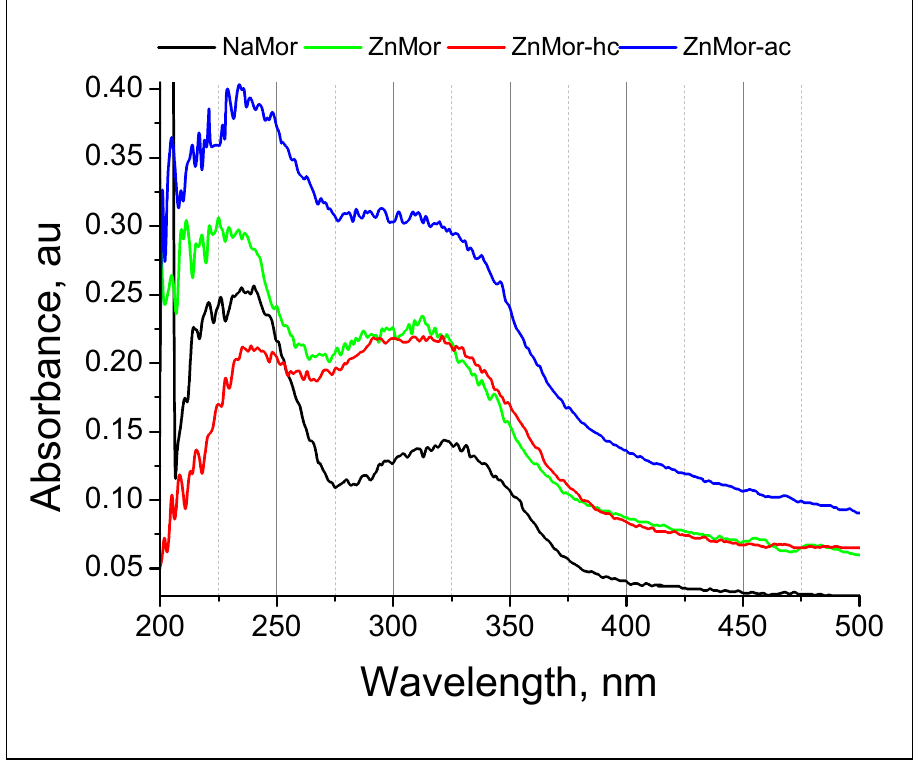
Figure 9. UV-Vis diffuse reflectance spectra of the 200–500 nm region of the selected samples: NaMor, ZnMor, ZnMor-hc and ZnMor-ac.